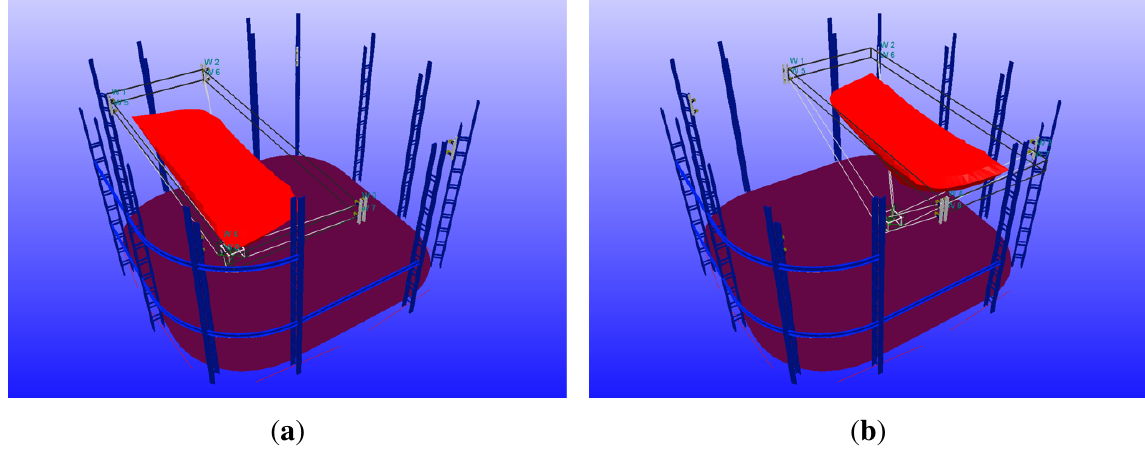
Figure 5. Calculated wrench-feasible workspace for the left ( a ) and right ( b ) cable robot integrated in the installation